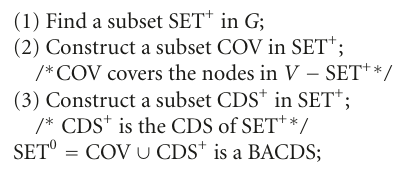
Algorithm 2: The outline of the BACDS